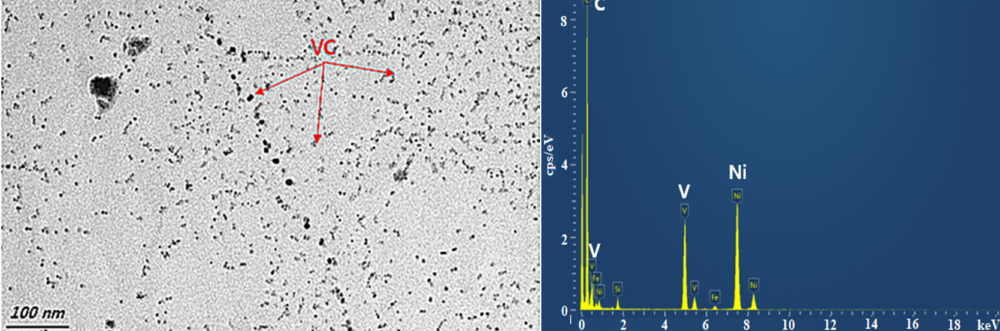
Figure 27. Fine VC precipitation in a 0.3% V containing TWIP steel both at the grain boundaries and within the matrix [22]. A Ni grid was used to support the replica.